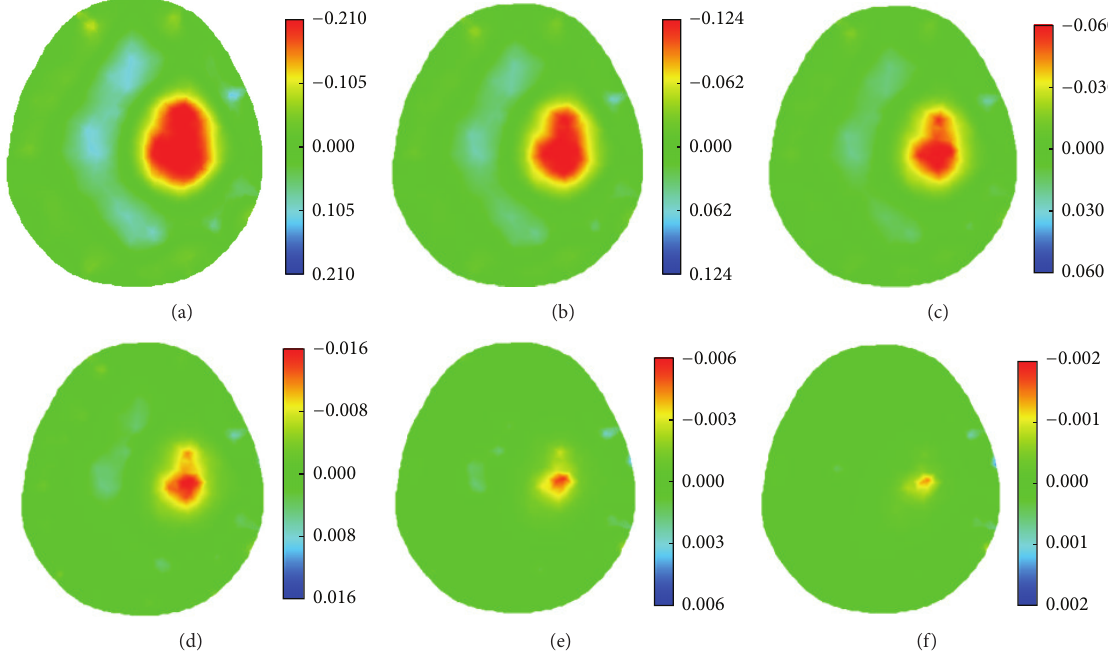
Figure 14: SEIT reconstructions of the simulated hemorrhagic stroke lesions of different sizes. Images (a) to (f) are SEIT reconstructions corresponding to the simulated hemorrhagic stroke lesion with a radius of 2.00, 1.50, 1.00, 0.50, 0.25, and 0.10cm, respectively.